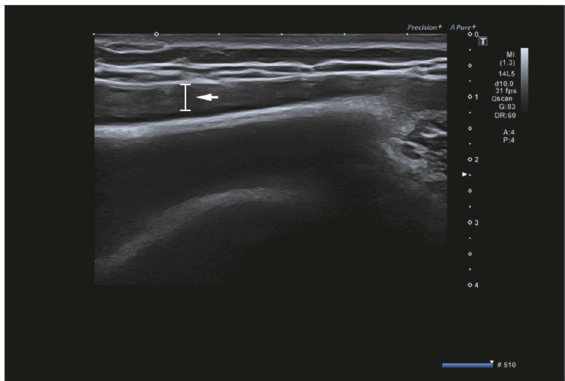
Figure 4: Ultrasound of the left breast demonstrates periprosthetic fluid reaction in the inner region (white arrow).